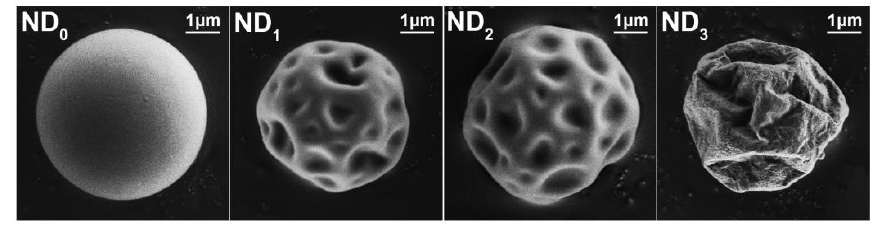
Figure 3. SEM images of NTM DPIs.